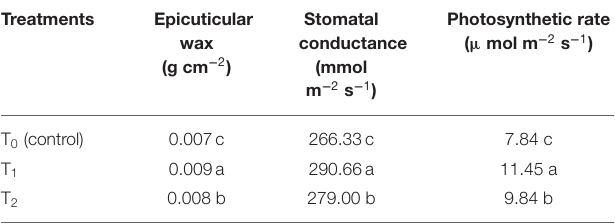
TABLE 3 | Effect of cytokinin-producing A. brasilense RA − 17 (T 1 ) and non-producing A. brasilense RA − 18 (T 2 ) on proline content, epicuticular wax, stomatal conductance, and photosynthetic rate of wheat at flag leaf